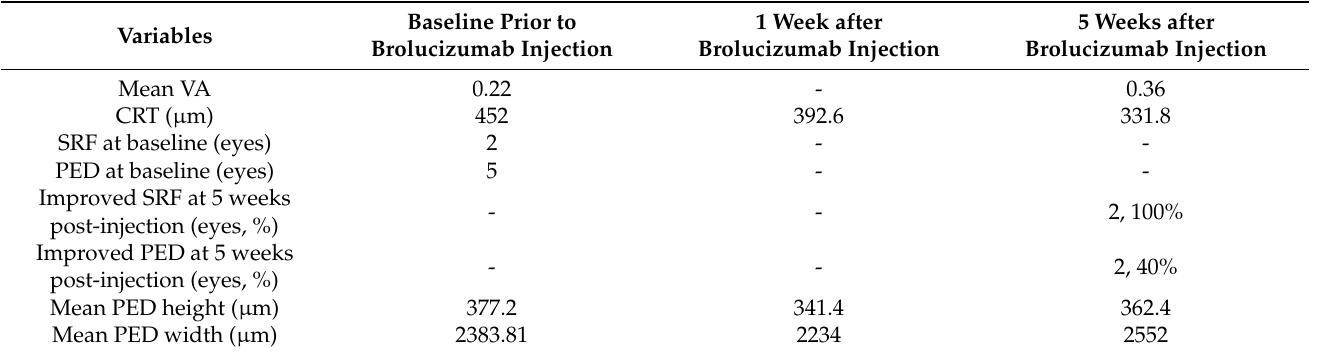
Table 4. Anatomical and visual outcomes in PCV patients at baseline before injection, 1 week and 5 weeks post-injection (PCV only: n =